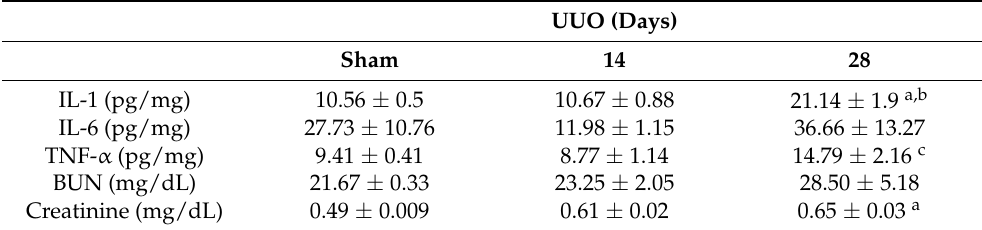
Table 2. Pro-inflammatory cytokine content and enzymes related to renal function in blood serum. Pro-inflammatory cytokines content in blood serum obtained from sham and unilateral ureteral obstruction (UUO) rats at 14 and 28 days by enzyme-linked immunosorbent assay (ELISA), as well as the creatinine and blood urea nitrogen (BUN) levels, were determined. Data are the mean ± SEM of 5–6 different animals in each experimental group a p ≤ 0.05 vs. sham; b p ≤ 0.05 vs. UUO 14 days; c p ≤ 0.05 vs. UUO 14 days. IL-6: interleukin-1; IL-6: interleukin-6; TNF- α : tumor necrosis factor